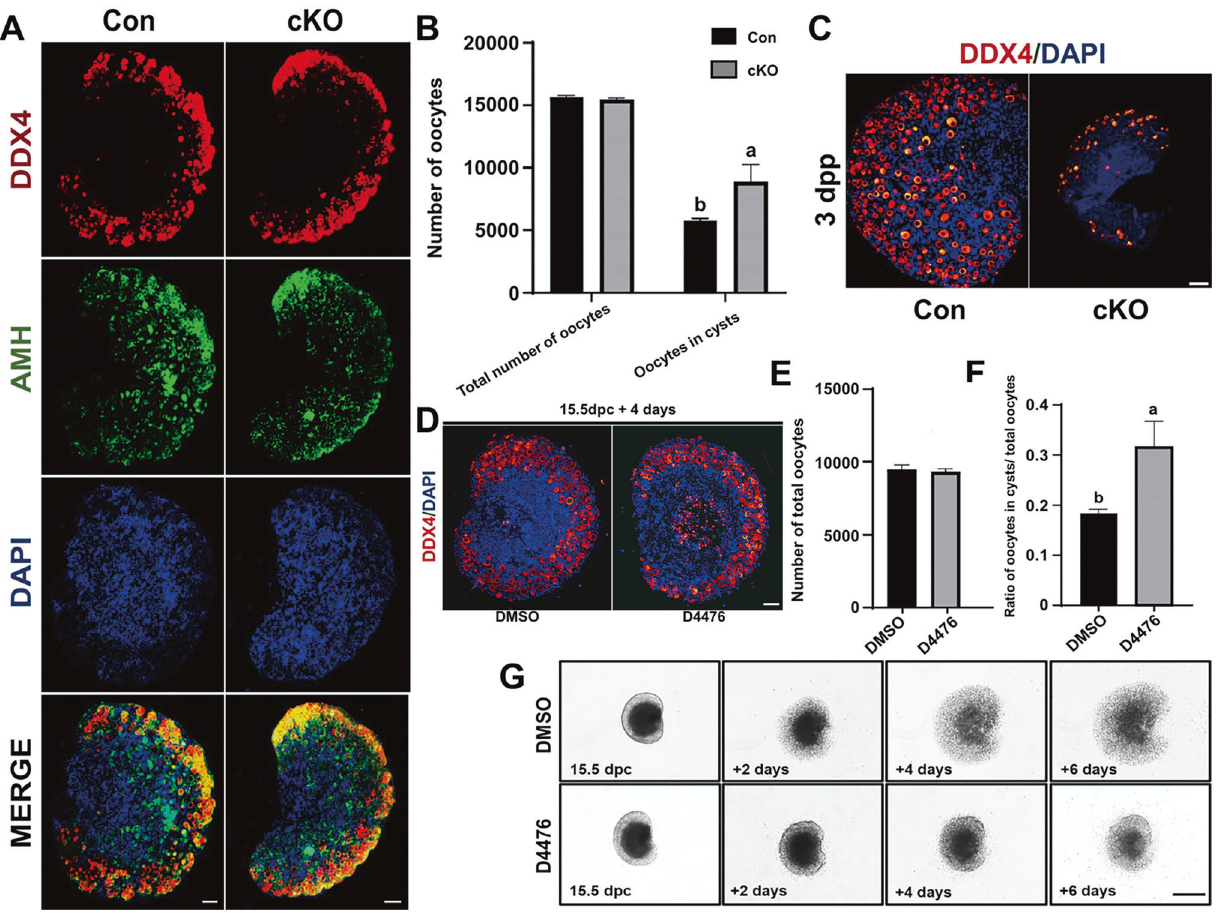
Fig. 4 In vivo and in vitro experiments detecting the effects of CK1 α inactivation on miotic proliferation, meiosis of the oogonia, and the formation of primordial follicles. A Representative images of DDX4 (red) and somatic cell marker AMH (green) immuno fl uorescent double staining in 1 dpp ovaries. DAPI (blue): nuclei. Scale bar: 50 μ m. B Number of total oocyte and oocytes in cysts from 1 dpp mice ovaries. Different letters indicate signi fi cant difference ( P < 0.05). Data are shown as means ± SEM ( n = 3). C IF staining of DDX4 (red) in 3 dpp mice ovaries. DAPI (blue): nuclei. Scale bars: 50 μ m. D DDX4 (red) staining in 15.5 dpc ovaries treated with 25 μ M D4476 for 4 days (15.5 dpc + 4 days). DAPI (blue): nuclei. Scale bars: 50 μ m. E Number of total oocytes and F the percentage of oocytes in cysts of 15.5 dpc + 4 days ovaries. Different letters (a and b) indicate signi fi cant difference ( P < 0.05). Values are the means ± SEM ( n = 3). G Embryo ovaries at 15.5 dpc were cultured and treated with D4476 (25 µM) or DMSO (control) for 2, 4, and 6 days, respectively. Scale bar: 100 μ